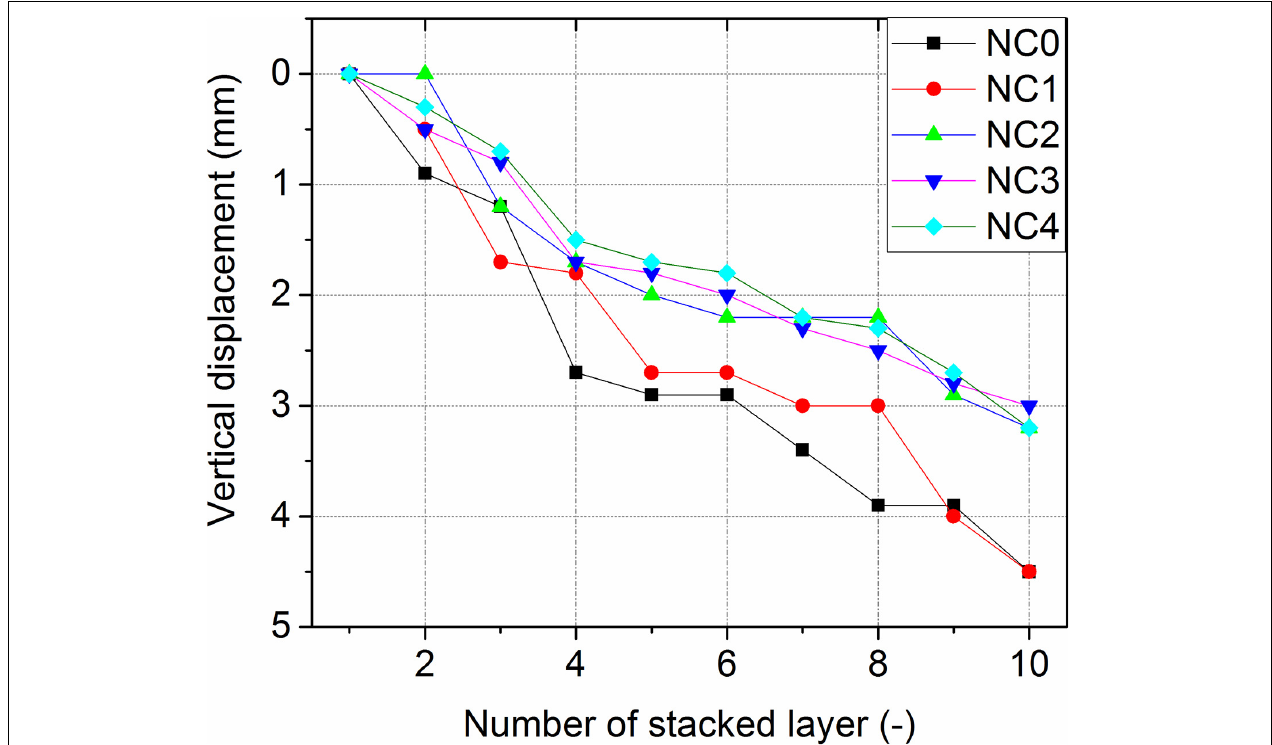
FIGURE 10 | Deformation under